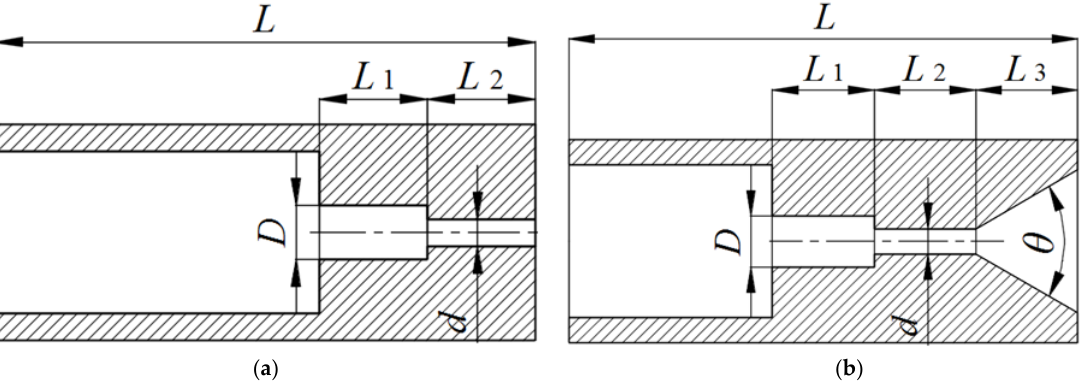
Figure 2. Geometry structure of the nozzles used in experiment. ( a ) Organ pipe nozzle (without whistle). ( b ) Organ pipe nozzle (divergent whistle).